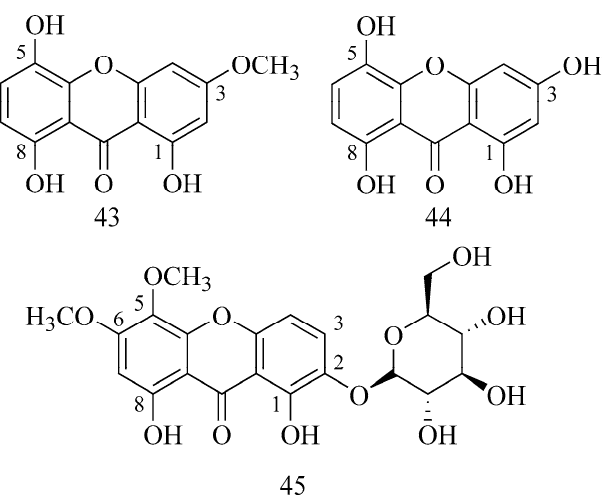
Figure 15. Chemical structures of bellidifolin ( 43 ), bellidin ( 44 ) and triptexanthoside C ( 45 ).